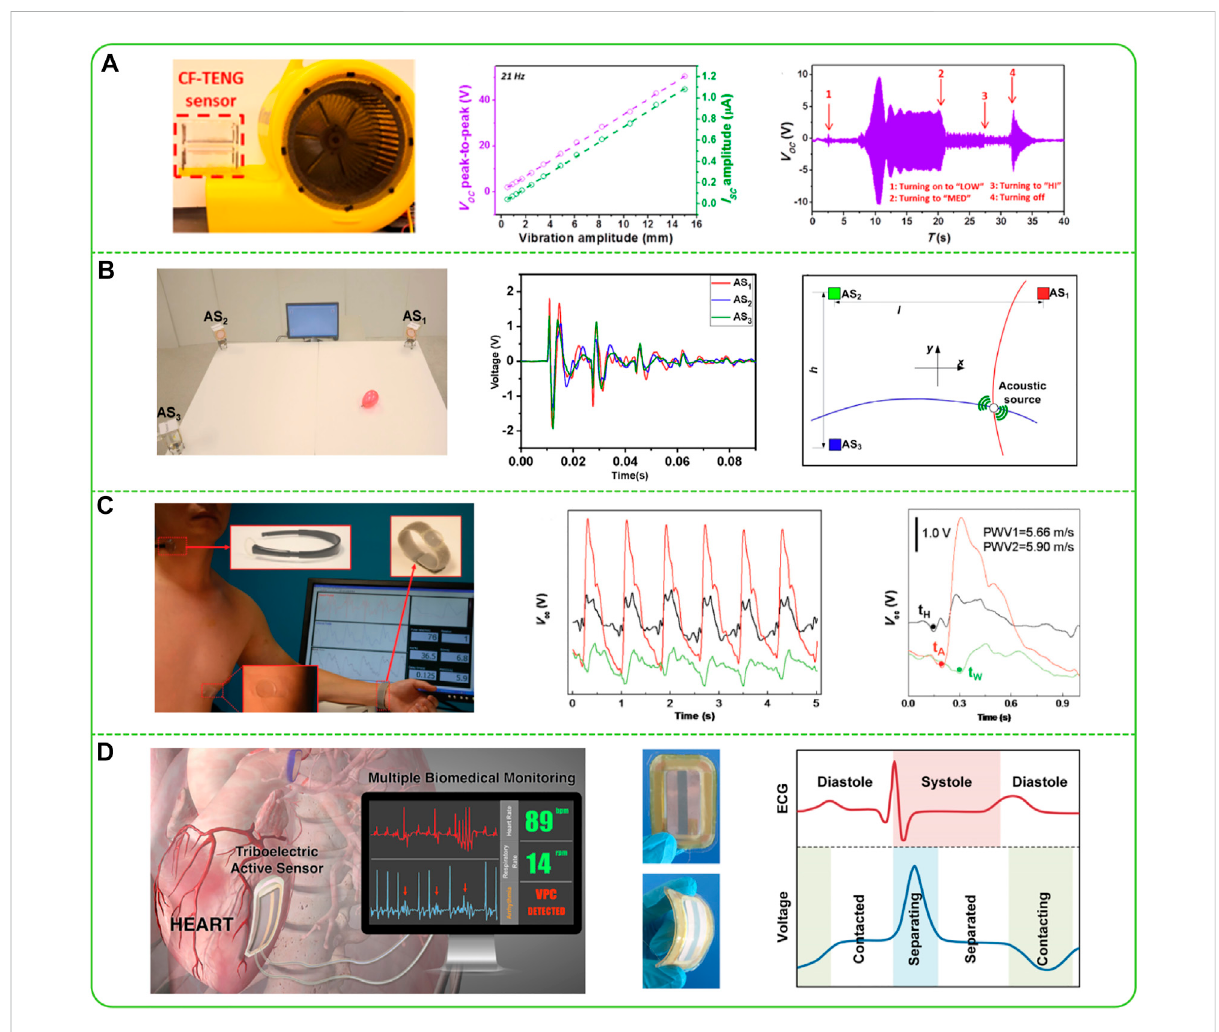
FIGURE 5 TENG-based self-powered sensors. (A) Photograph showing the demonstration of using the CF-TENG to monitor the vibration of a wind blower during its operation, the output voltage and current from the CF-TENG triggered by vibrations with different amplitudes, the output voltage fromtheCF-TENGwhenthewindblowerwassequentiallyswitchedtodifferentspeeds(Wangetal.,2014). (B) Photographandschematicillustration showing the working mechanism of nanogenerators for sound localization, acquired acoustic signals from the three nanogenerators when a balloon burst (Yang et al., 2014). (C) Implementation of BMS, the pulse waves acquired from three different sites of a participant: carotid artery, left wrist,andthechest,andanenlargedviewofacycleofoutputsignalscorrespondingtothreepositions(Yangetal.,2015). (D) Schematicdiagramand photograph of iTEAS and the schematic correspondence between iTEAS and different phases of heart motion (Ma et al.,